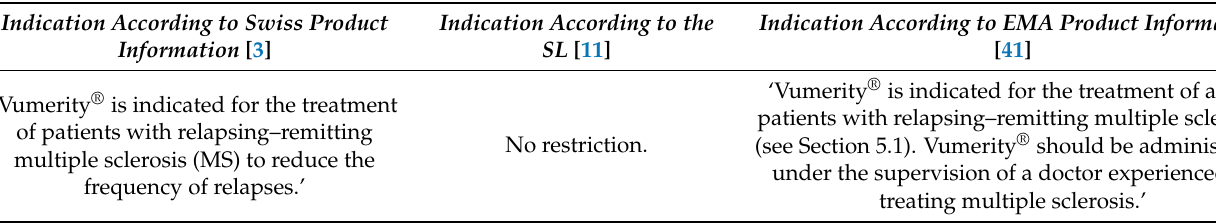
Table 2. Diroximel fumarate (Vumerity ® ), approval CH